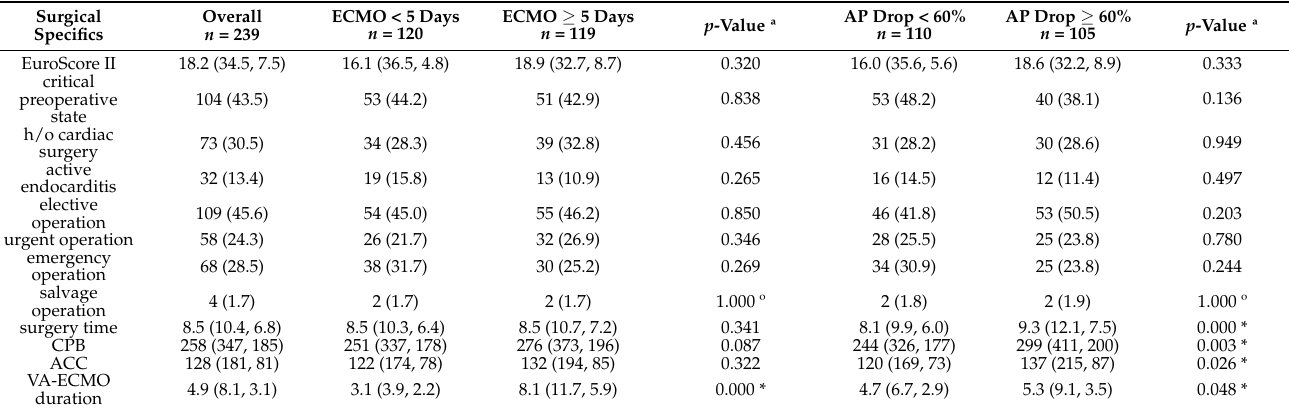
Table 2. Procedural